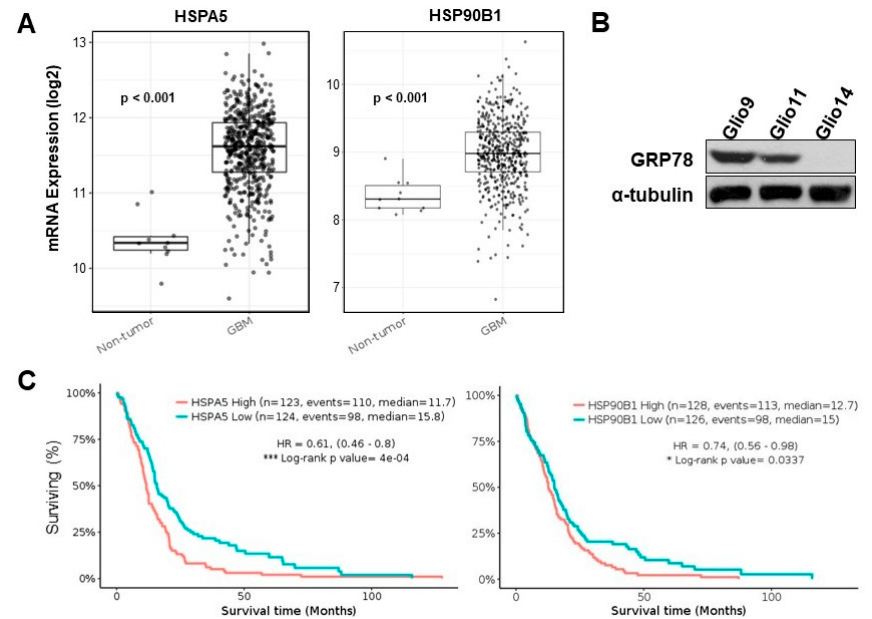
Figure 3. Upregulation of UPR genes in human GBM specimen correlates with reduced patient survival. ( A ) Comparison of non-tumor ( n = 10) and GBM sample ( n = 528) for mRNA expression of ER stress genes HSPA5 and HSP90B1 . Pairwise t -test. ( B ) Western blot analysis for baseline levels of GRP78 in Glio9, Glio11, and Glio14. ( C ) Kaplan-Meier plot of survival using the GlioVis portal comparing low expression (25th percentile) and high expression (75th percentile) of HSPA5 and HSP90B1 . Results reported as hazard ratio (95% confidence interval). * p < 0.05, *** p < 0.001. Log-rank test. Events = number of patients who died. See also Figure